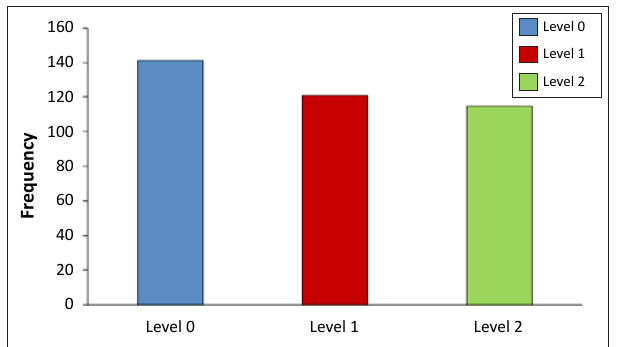
FIGURE 4: Comparison of the quality of the